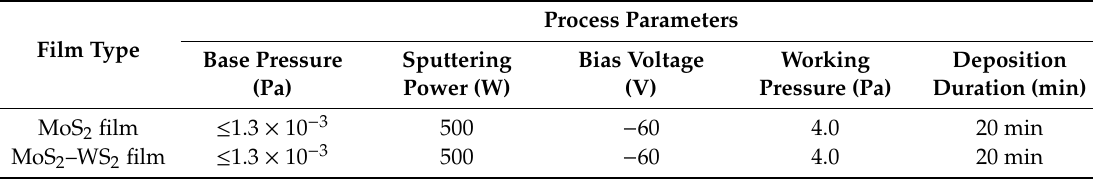
Table 1. The deposition parameters of composite and pure lubricating